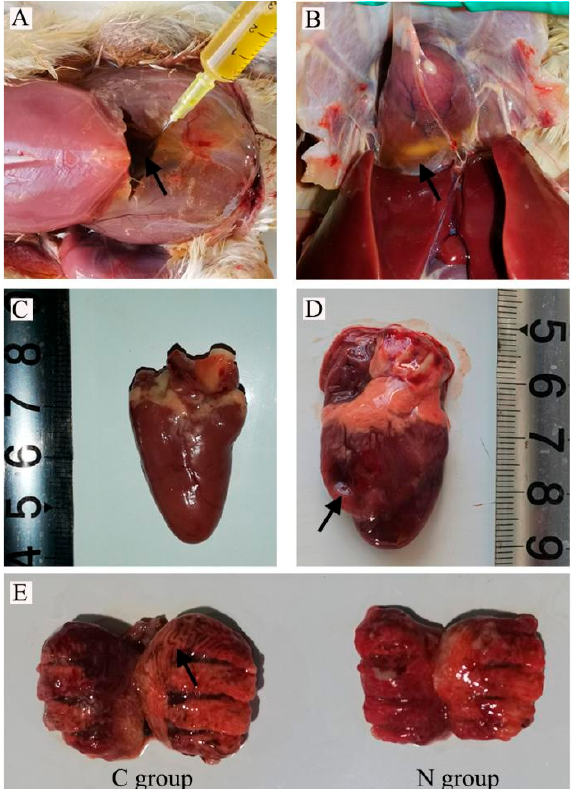
Figure 1. Dissection of the lesions associated with broiler ascites syndrome (arrow). ( A ) Removal of a large amount of yellow fluid accumulated in the abdominal cavity. ( B ) Obvious pericardial effusion. ( C ) Normal broiler heart. ( D ) Ascites syndrome broiler heart showing significantly increased heart volume, and the right ventricle dilated and thinned. ( E ) C group: ascites syndrome broiler enlarged lungs with gray and white striations in the interstitium. N group: normal broiler lungs.